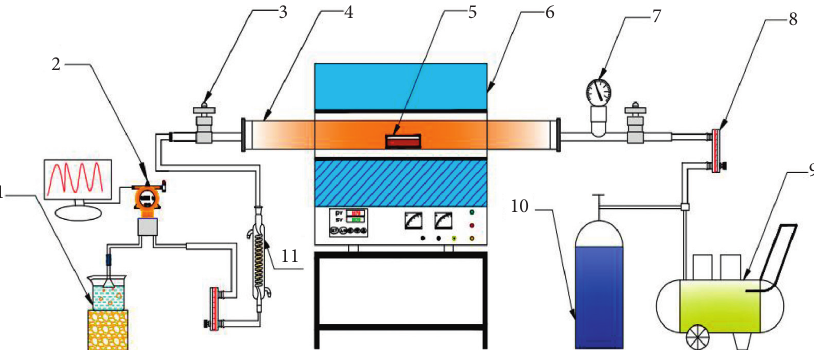
2 , (3) flow control device, (4) furnace tube,